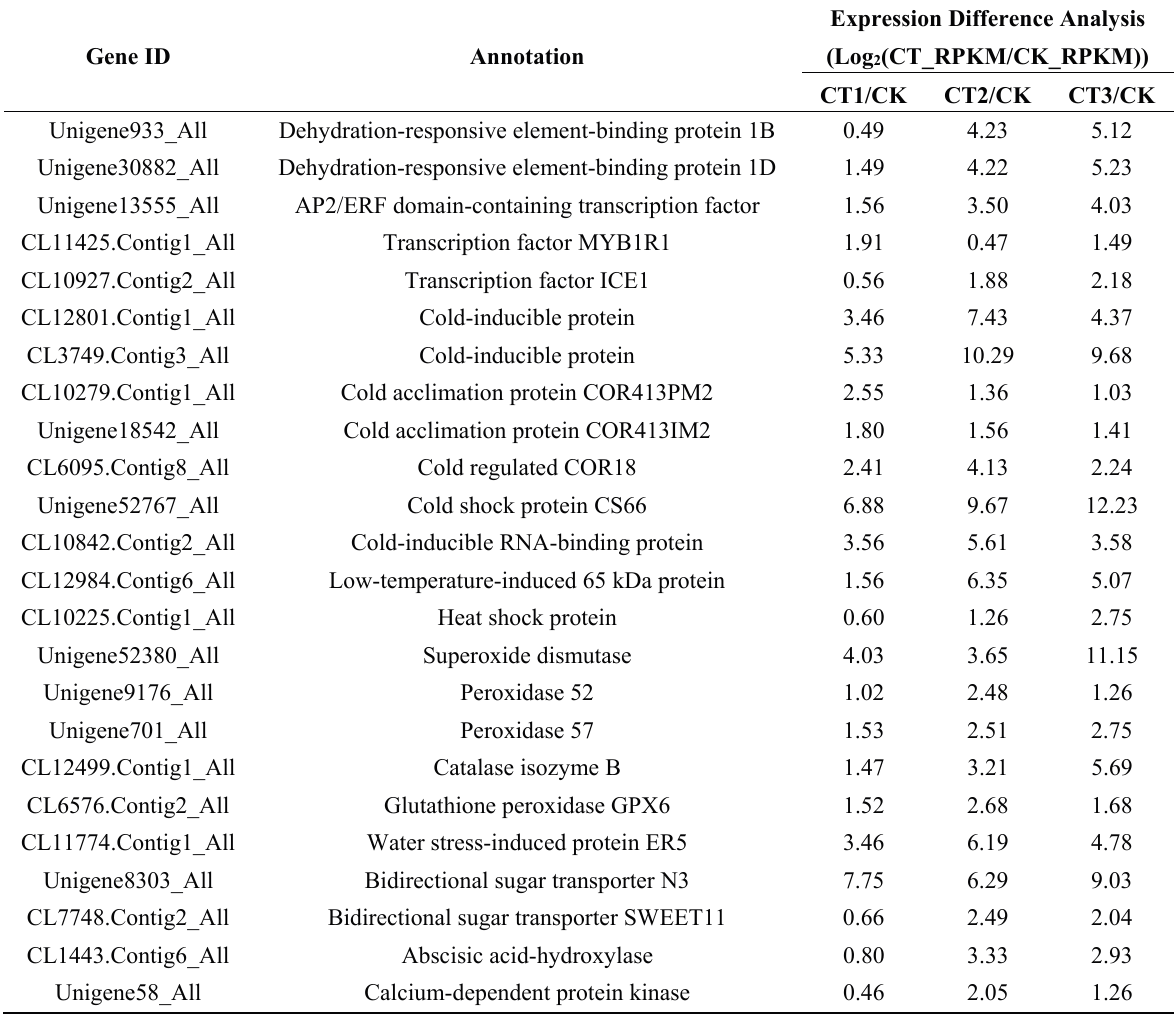
Table 4. Analysis of differences in the expression of genes up-regulated in response to cold stress in Phlox subulata